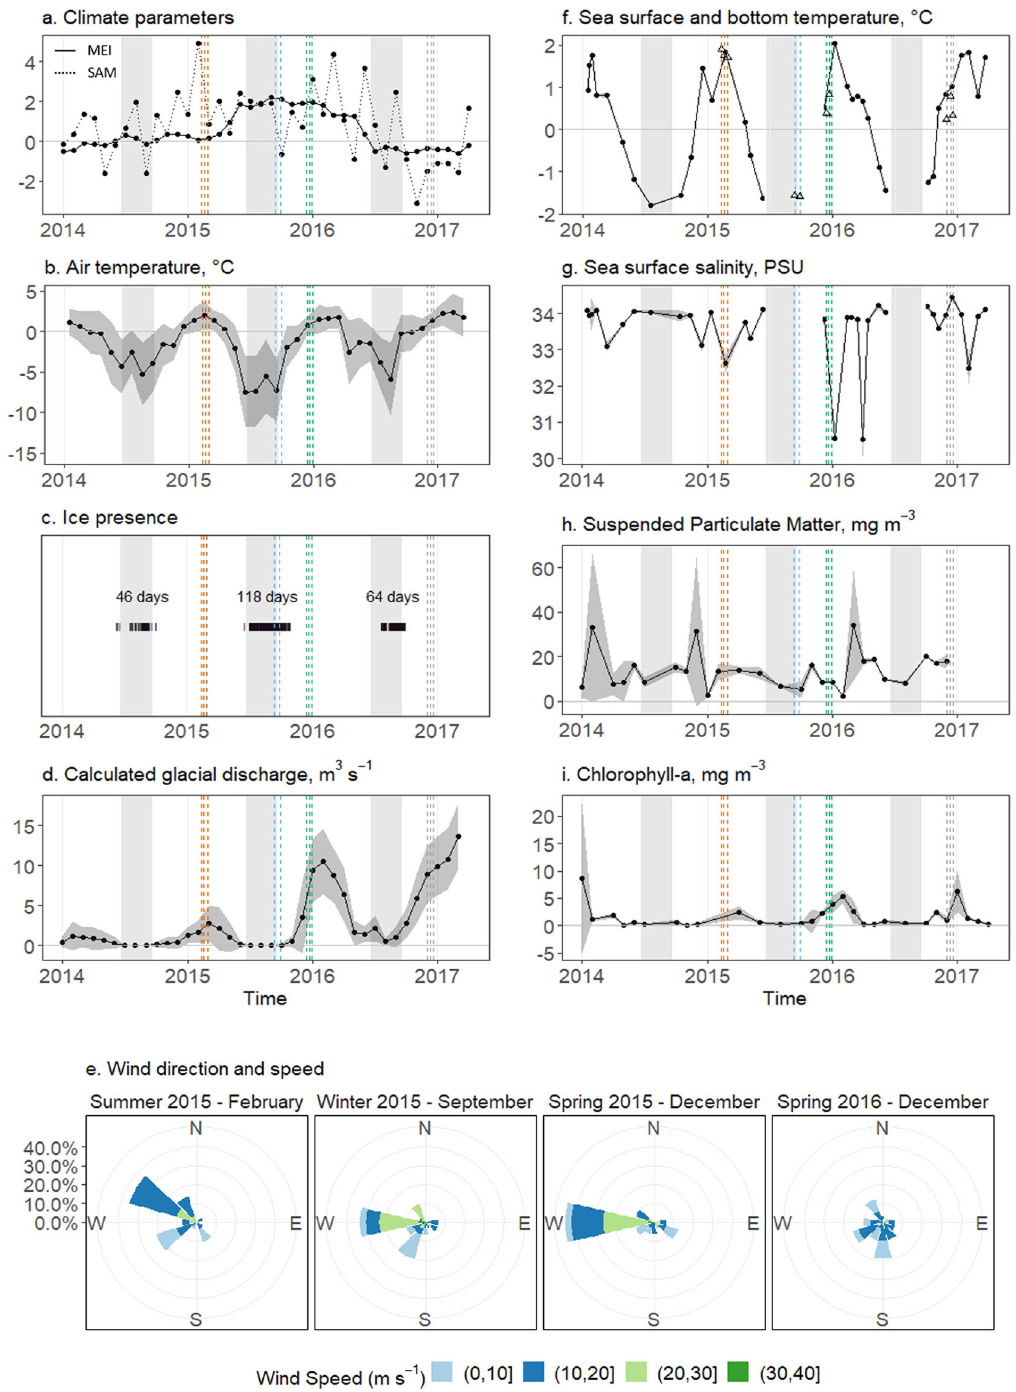
Fig. 2 Environmental parameters. a Monthly averages of the multivariate ENSO index (MEI v2) and southern annular mode (SAM), b average monthly air temperature, c daily sea ice presence, d monthly averaged modelled glacial discharge, e wind speed and direction during the months of the in situ incubations, with contours indicating the percentage of time the wind had a particular direction, f average sea surface temperature (0 – 1 m water depth) of inner Potter Cove ( fi lled dots), and average bottom water temperature measured during benthic chamber incubations at each site (open triangles), g average salinity, h SPM, and i chl- a in the surface waters (0 – 1 m water depth) of inner Potter Cove from 2014 to 2017. In panels a – d and f – i , grey ribbons represent standard deviation; vertical dashed lines indicate the dates of the in situ incubations in summer 2015 (orange), winter 2015 (blue), spring 2015 (green) and spring 2016 (grey); grey zones indicate the astronomical austral winter; limited data coverage of sea surface temperature and salinity in autumn and winter 2015 and 2016 is shown as disconnected data points. Source data can be found in Supplementary Dataset